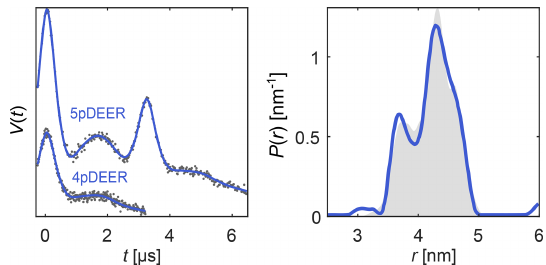
Figure 7. Global analysis of a four-pulse DEER signal and a five- pulse DEER signal with its secondary four-pulse pathway contri- bution, both derived from the same distance distribution. The sim- ulated data are given as grey dots, the ground truth distribution is given as a shaded area, and the signal and distribution fits are given as solid blue